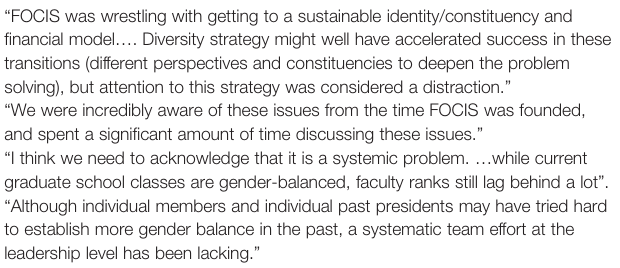
TABLE 2 | Quotes from FOCIS